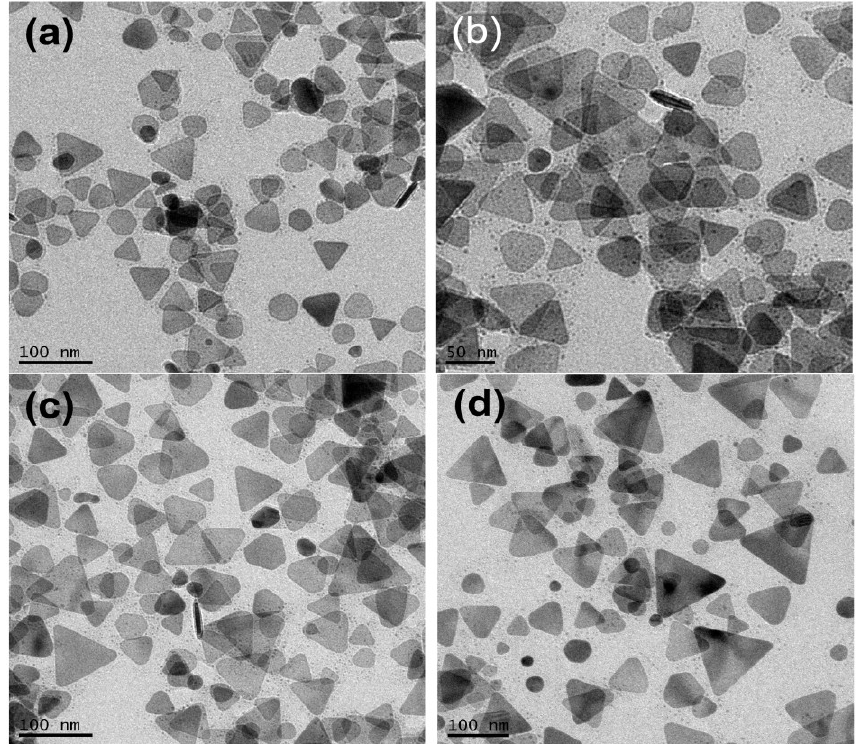
Figure 9. TEM images of the silver nanoparticles synthesized at 40 °C and at different reaction times: ( a ) 90 min; ( b ) 140 min; ( c ) 210 min and ( d ) 11.5